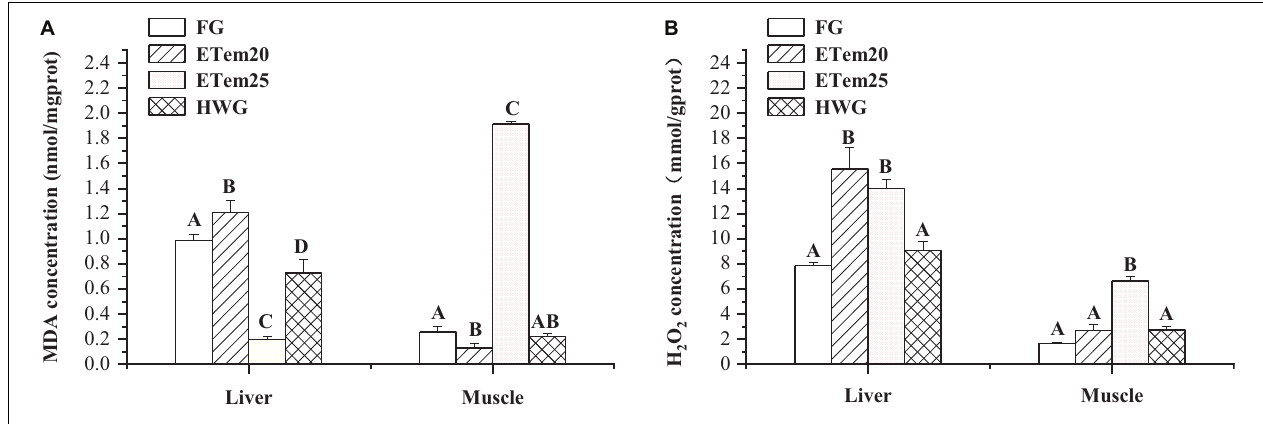
FIGURE 4 | Changes in panel (A) malondialdehyde (MDA) and (B) H 2 O 2 level in the liver and muscle of N. pleskei ( n = 8) in different temperature acclimation groups and field group. The sample size of each group was eight. The significant difference was shown by comparing all the groups. Different characters mean P < 0.05. TABLE 3 | Glutathione status in the liver and muscle of N. pleskei in different temperature acclimation groups and field group.